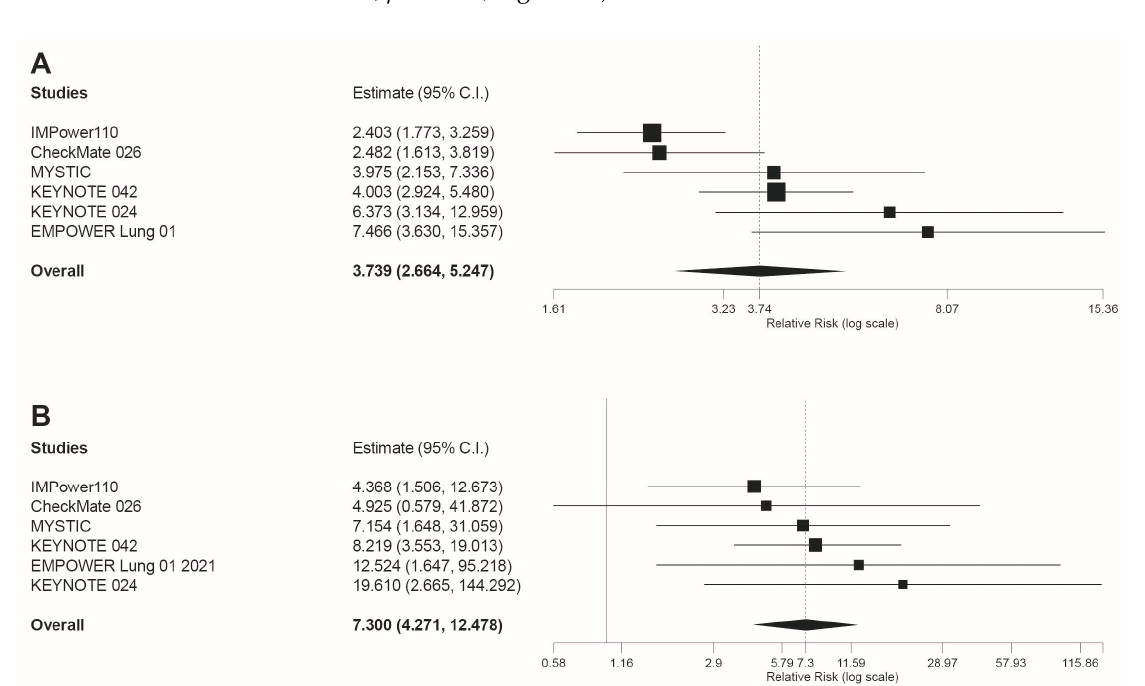
Figure 3. Forest plot of pooled risk ratios (RR) for ( A ) any grade irAEs and ( B ) grade 3–4 irAEs, in patients treated with anti-PD-1 or anti-PD-L1 immunotherapy compared to platinum-based chemotherapy. Estimate, RR; CI: confidence interval. Treatments are presented top to bottom by lower to higher RR. Black squares indicate the weight of each RCT in the MA. The black rhomb indicates the weighted overall RR for immunotherapy versus chemotherapy. The I 2 index values measuring the heterogeneity of effect-size estimates from the in-dividual studies in MAs A and B correspond respectively to: (I 2 = 68.48%, p = 0.007) and (I 2 = 0%, p = 0.804).